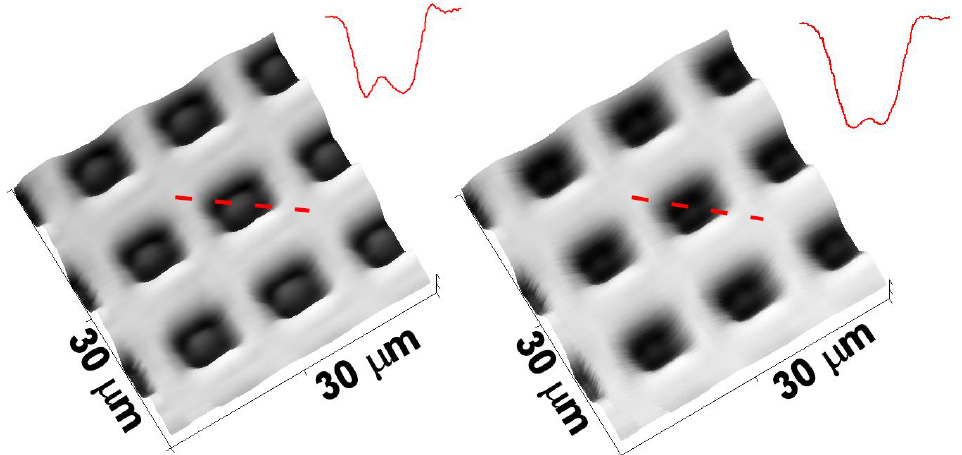
Figure 9. AFM Calibration sample image at: ( a ) λ = 550 nm; ( b ) λ = 650 nm. The lateral side of the images is 30 μm. The measured intensities profiles are indicated by the dashed